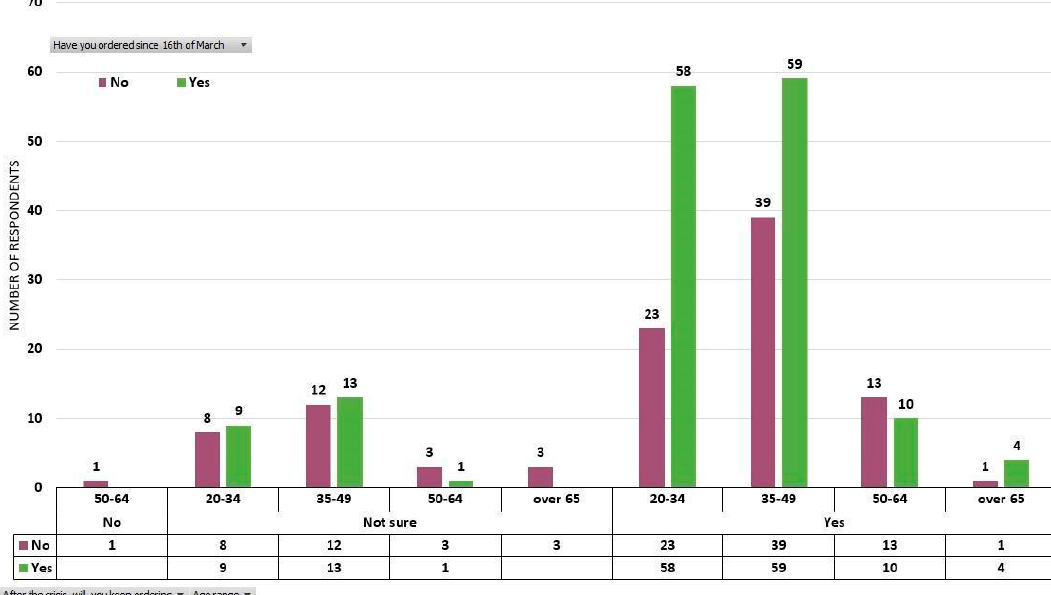
Figure 7. The clusters of those who declared that they bought or did not buy directly delivered fresh vegetables from local producers after March 16, distributed according to age categories and statements that they will keep buying or not from local producers after the COVID-19 crisis.